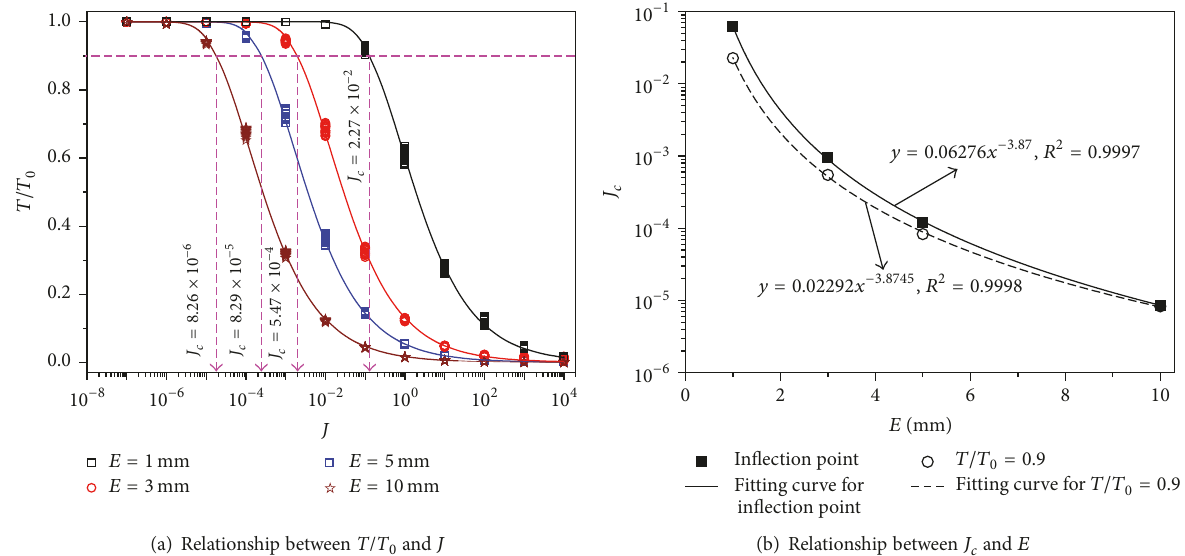
Figure 16: Relationships between (a) T / T 0 and 𝐽 and (b) 𝐽 𝑐 and 𝐸 based on the data replotted from Liu et al. ([113], Figure 4 ).